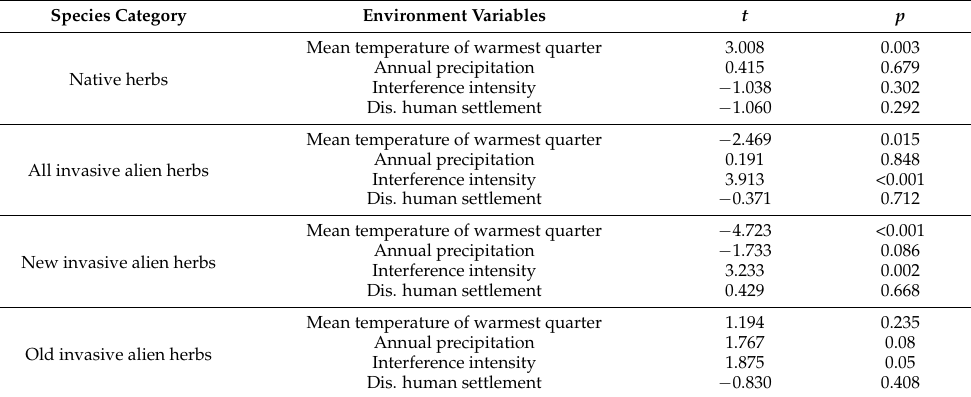
Table 1. Linear models were constructed for native herbs, all invasive alien herbs, the richness levels of new and old invasive alien herbs, and various environmental factors at the altitude gradient of the